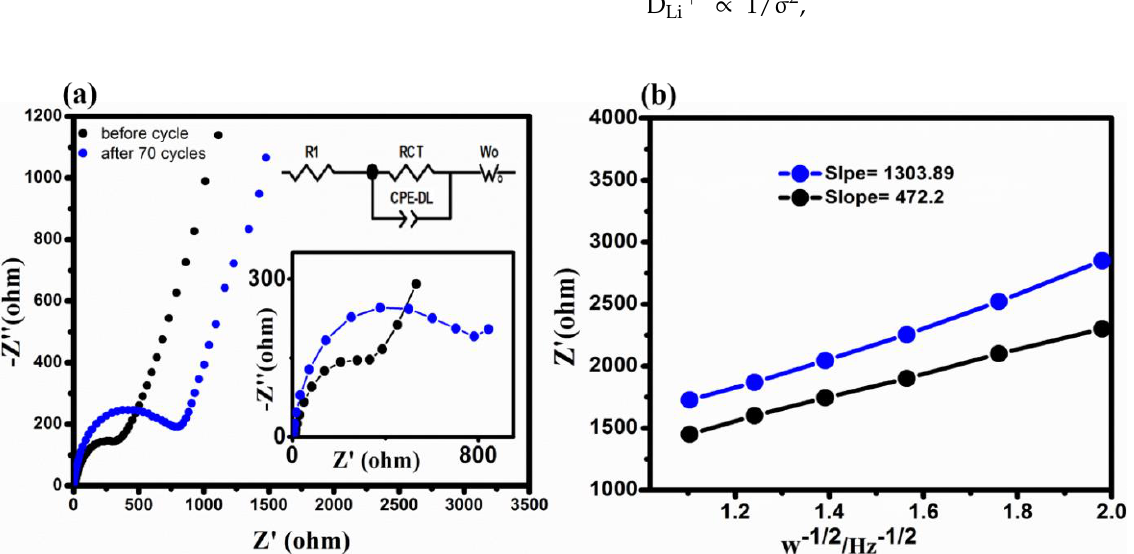
Figure 5. ( a ) The Nyquist plot of CSs@Se composite before and after cycling with Rct values plotted and equivalent circuit inserted. ( b ) Fitted lines of impedance, Z ′ vs. angular frequency w ‐1/2 (before cycling and after 70 cycles). Table 1. Shows the different circuit element values for CSs@Se composite before cycling.